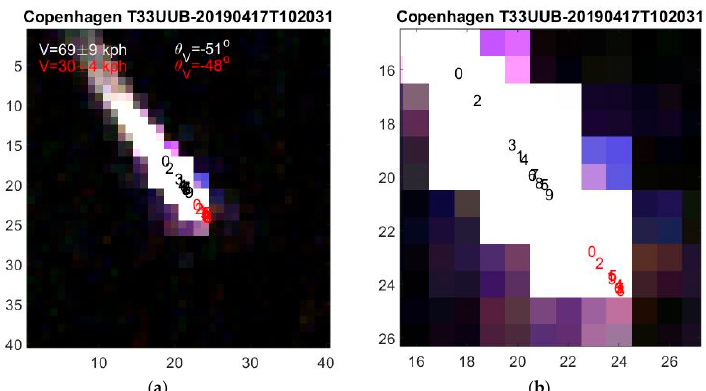
Figure 7. ( a ) As Figure 6 but for a fast ship creating a long wake, which corrupts the temporal ordering. Adding ship lengths L m to central position as shown with red numbers in ( b ) improves the temporal ordering and velocity determination.